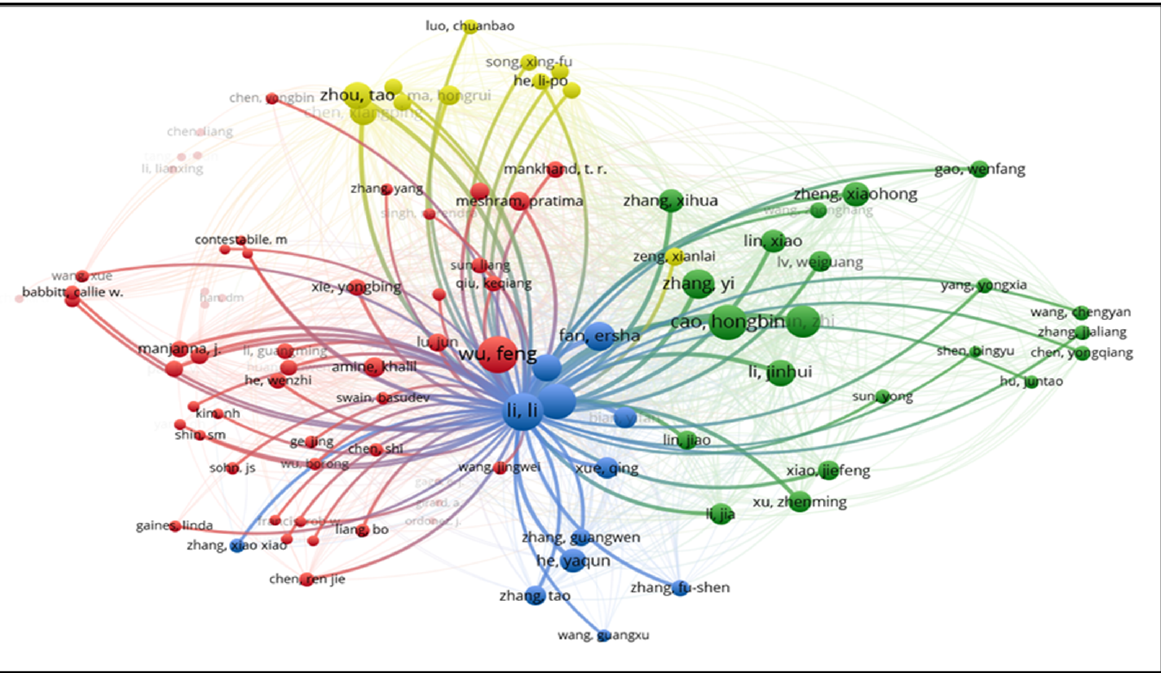
Figure 14. VOS Viewer Network Visualization of the 100 most cited authors.